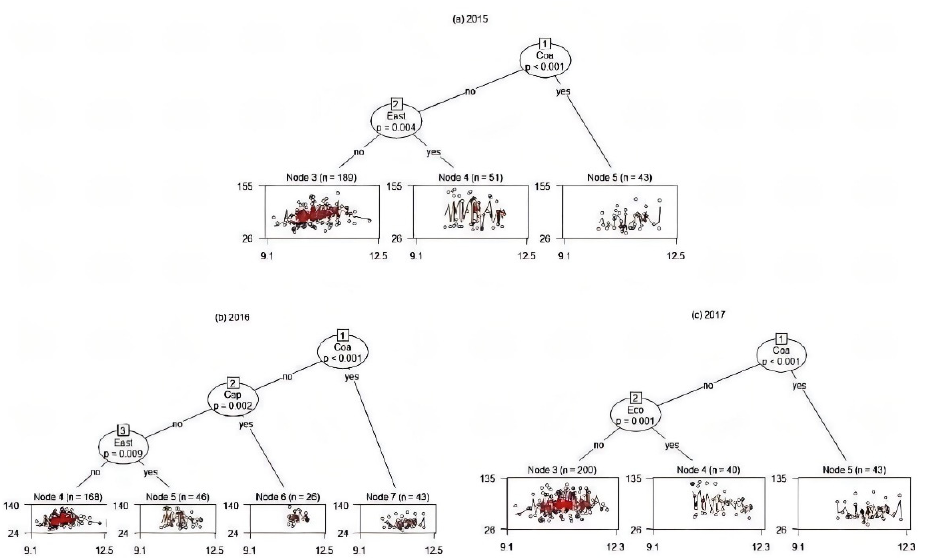
Figure 3. Regression tree for 2015, 2016 and 2017. Notes: In graph ( a ) or ( c ), Nodes 1 and 2 of the decision tree show the filtered partitioning variables, the p-values are from the parametric stability tests, and the red lines of Nodes 3, 4 and 5 show the scatterplot between AQI and LnPgdp in 2015 or 2017. In graph ( b ), Nodes 1, 2 and 3 of the decision tree show the filtered partitioning variables, and the red lines of Nodes 4, 5, 6 and 7 show the scatterplot between AQI and LnPgdp in